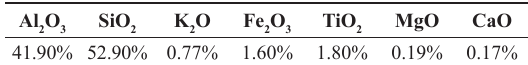
Table 2. Metakaolin